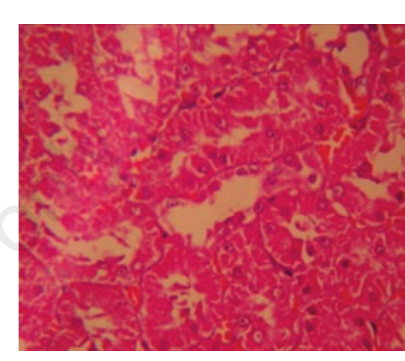
cells.Figure 1. Liver of control group showing normal structure.